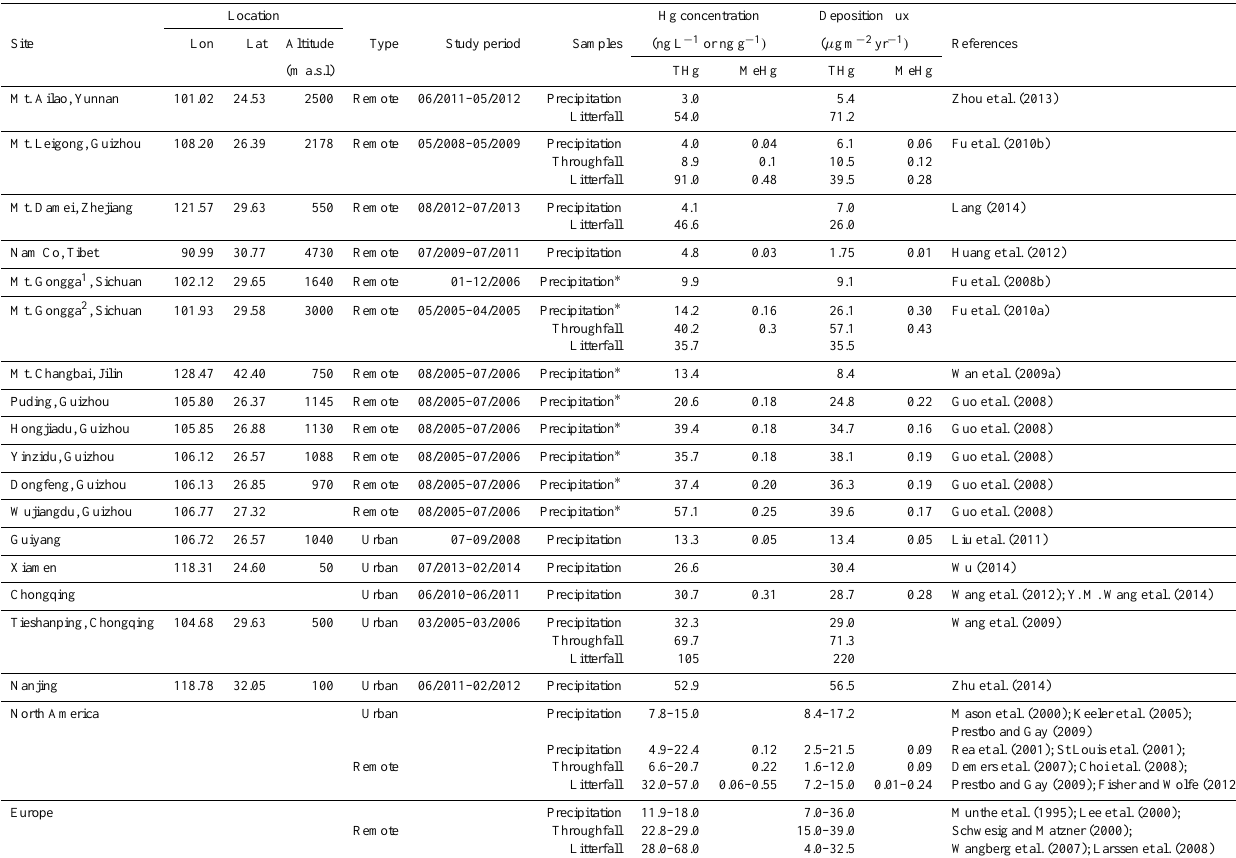
Table 3. Hg concentrations and deposition fluxes in precipitation, throughfall, and litterfall in China and other regions.